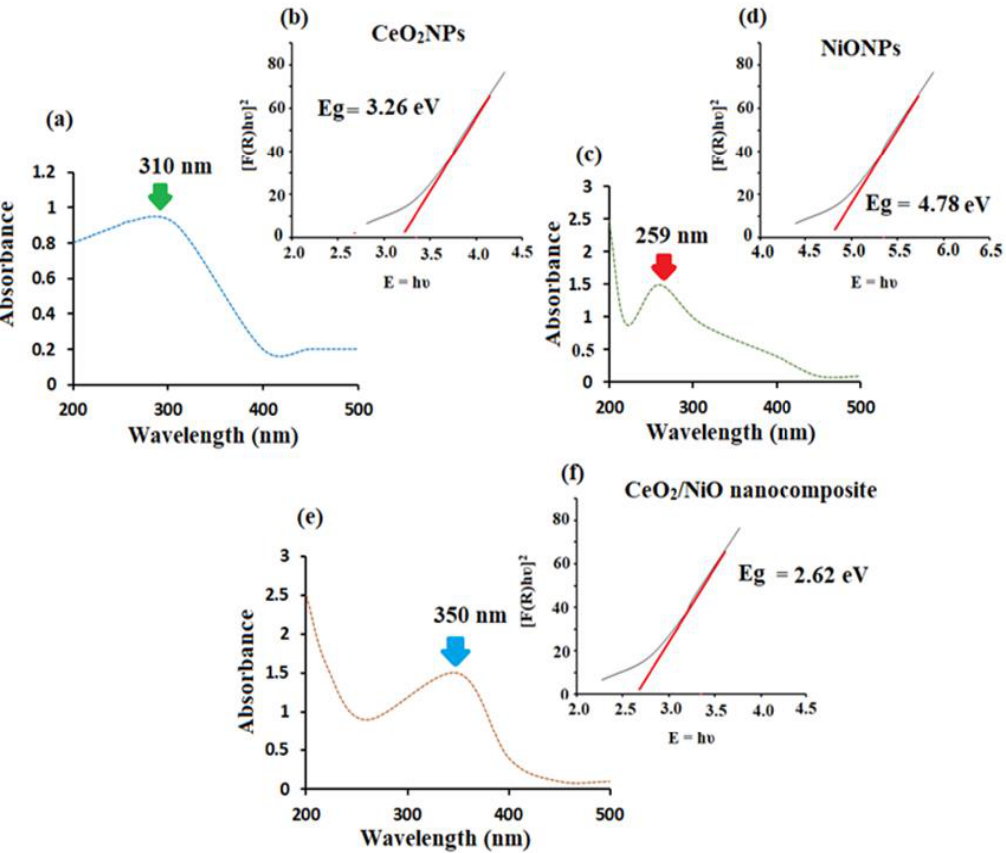
Figure 1. ( a , c , e ) UV-vis absorption spectrum, ( b , d , f ) band gap of green-synthesized CeO 2 NPs and NiONPs using wheat ( Triticum aestivum ) and rice ( Oryza sativa ) husk extracts, and their CeO 2 /NiO nanocomposite, respectively, measured at 200 – 500 nm.